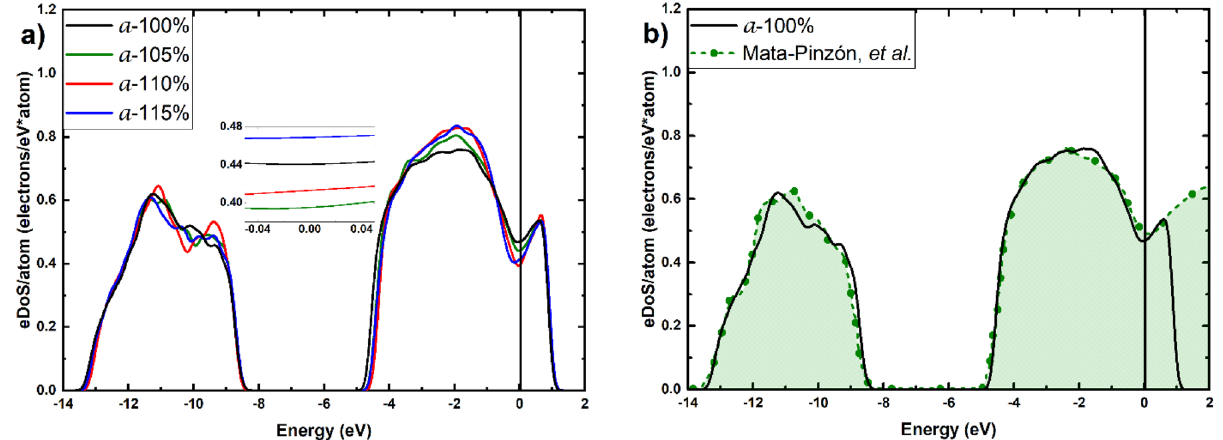
Figure 4. ( a ) eDoS per atom for the non-expanded and the expanded amorphous supercells of this work, obtained with a mesh of 3 × 3 × 3 k -points. The inset shows the behavior in the vicinity of the Fermi energy. ( b ) Our eDoS for 100% a-Bi compared to the simulations Ref. 10